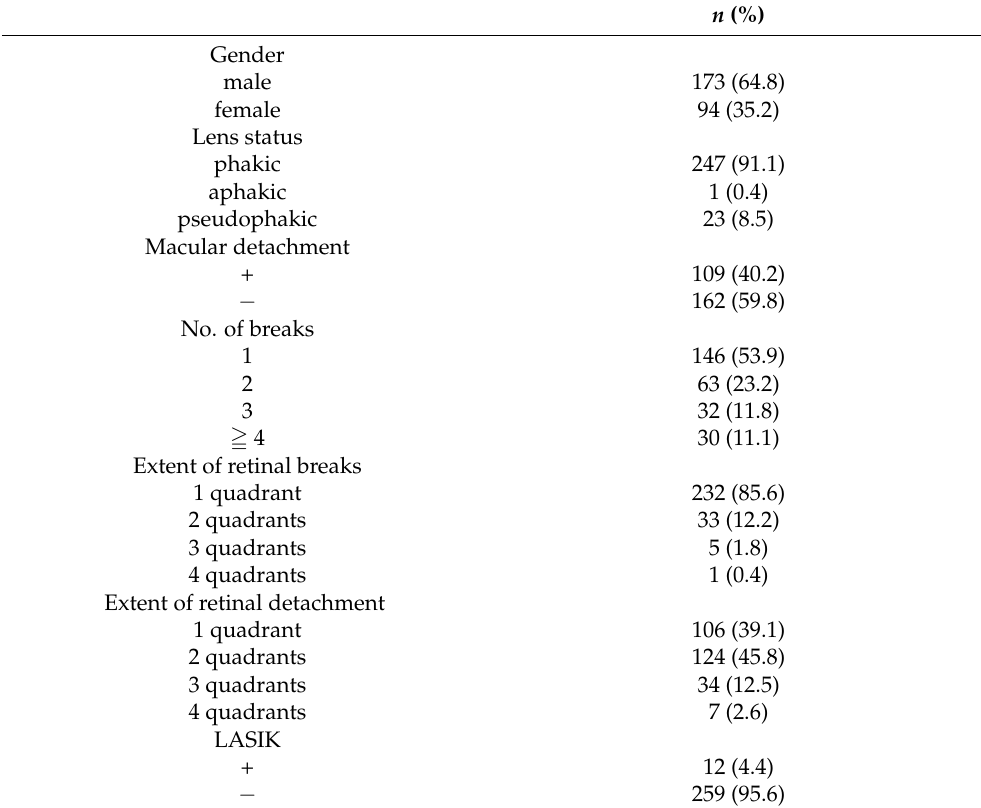
Table 1. Baseline clinical characteristics of patients who underwent scleral buckling